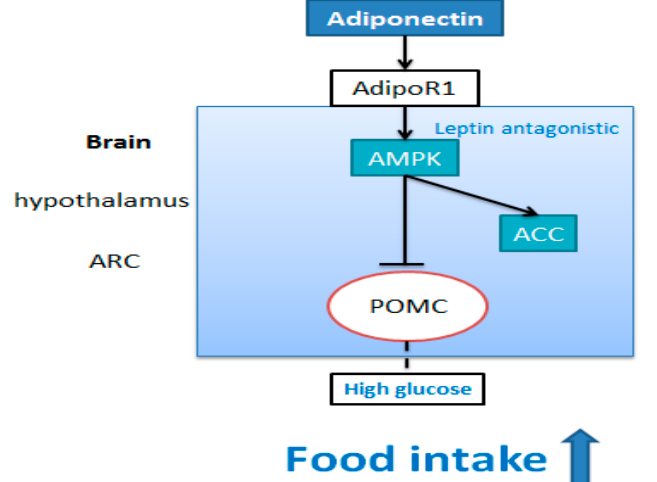
Figure 4. The stimulative effect of adiponectin on food intake. In the arcuate nucleus of the hypothalamus, adiponectin may bind to AdipoR1 in the arcuate nucleus of the hypothalamus to stimulate AMPK pathway and inhibit the excitation of POMC neurons. The inhibitory effect of AdipoQ on POMC neurons was closely related to high glucose concentration and AMPK pathway.